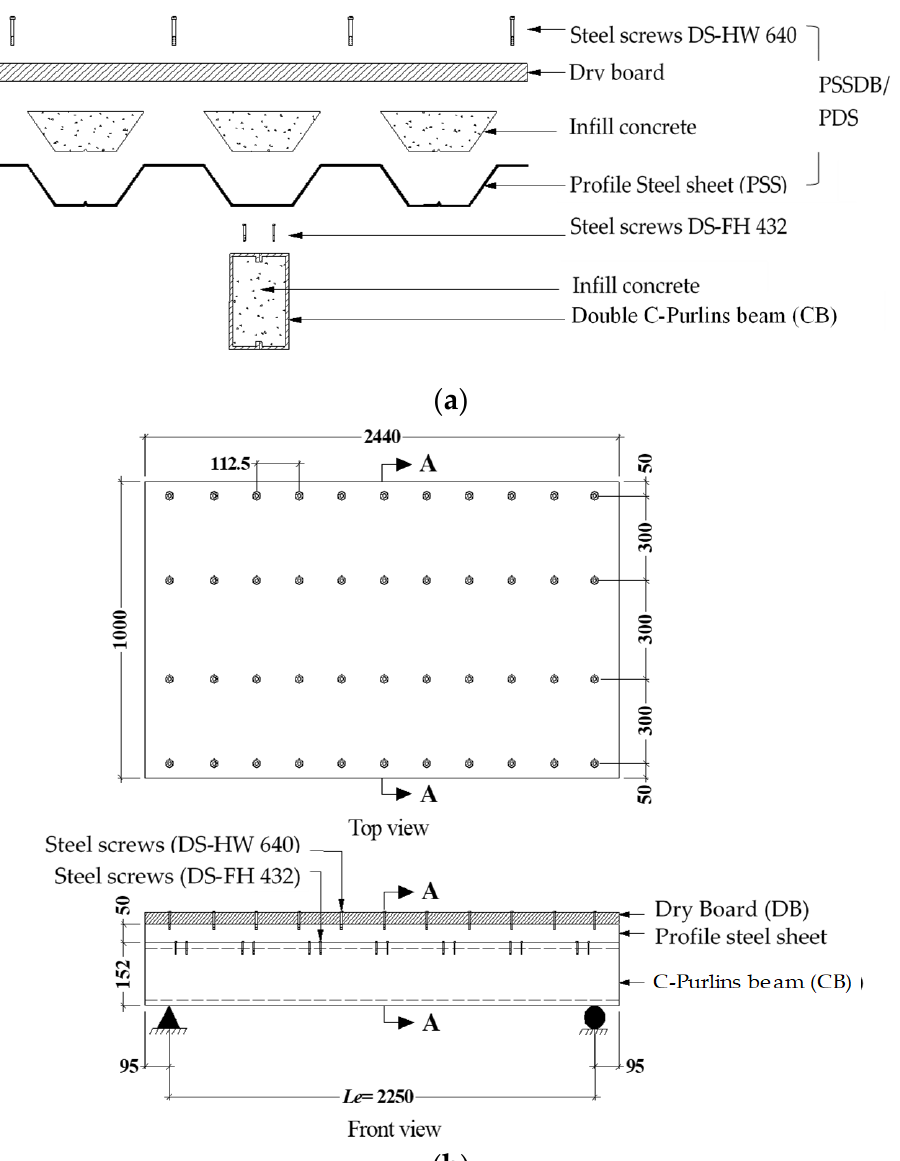
Figure 2. The composite CBPDS system (units in mm). ( a ) Components of CBPDS specimen; ( b ) Combination of the beam (CB) and slab (PDS).